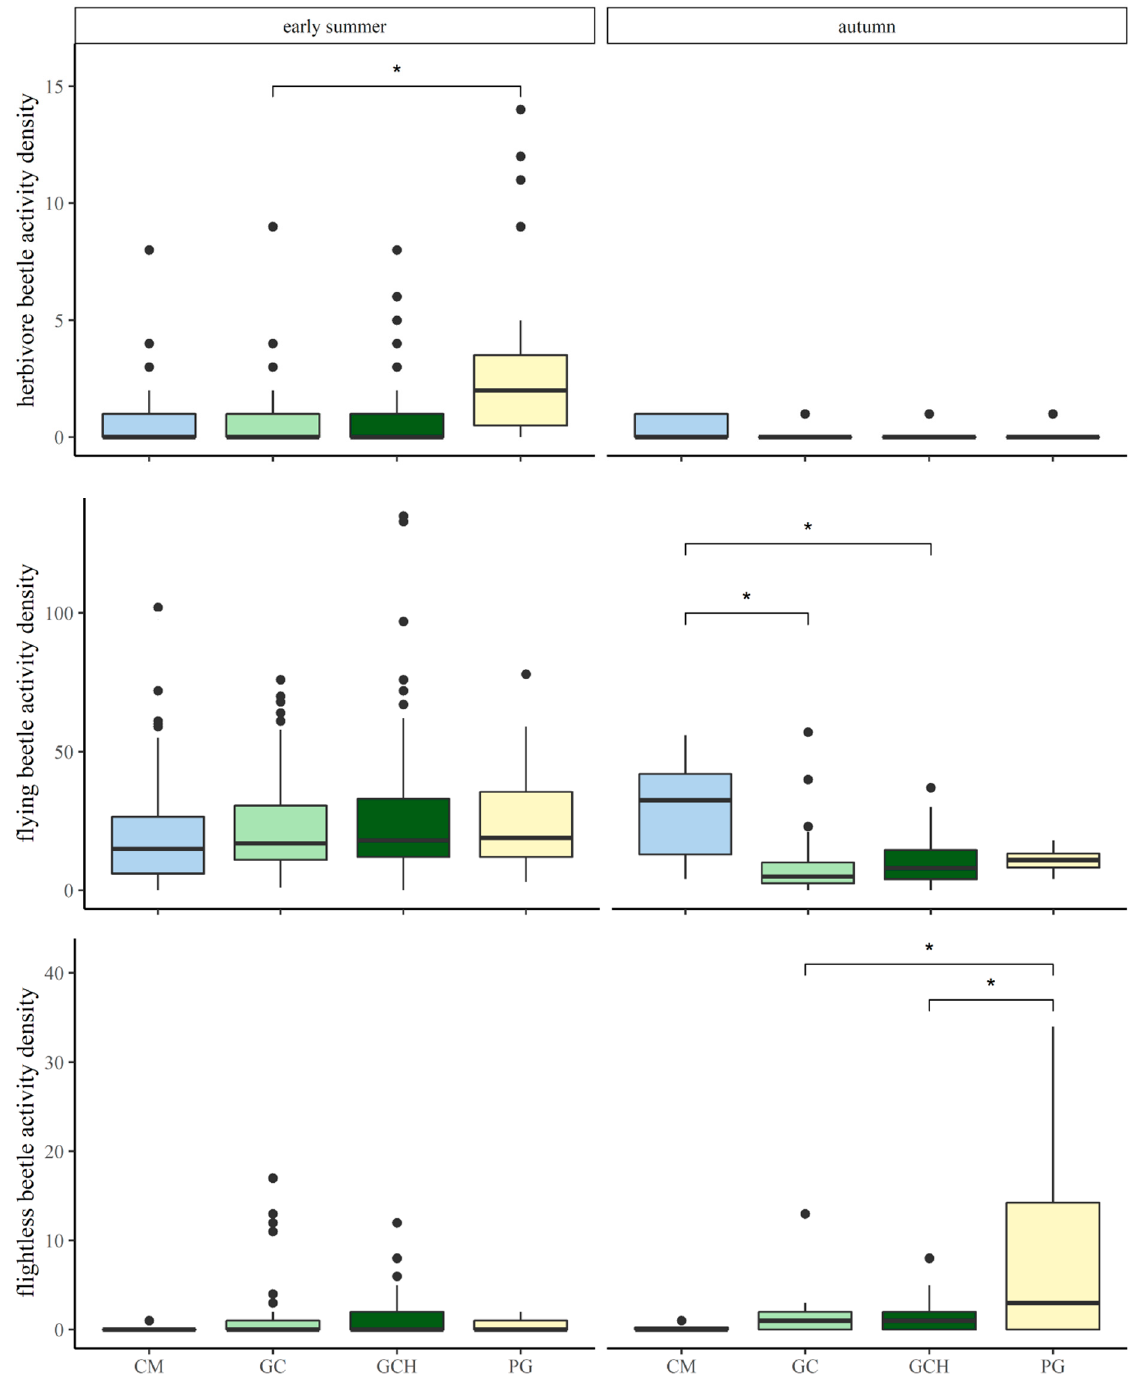
Figure 5. Trait-specific activity densities of herbivorous carabid beetles, and carabid beetles with a high mobility or low mobility of organic grass–clover (GC) and organic grass–clover herbs (GCH), in comparison to conventional maize (CM) and organic permanent grasslands (PG), in early summer and in autumn. p -values are indicated as * p < 0.05.